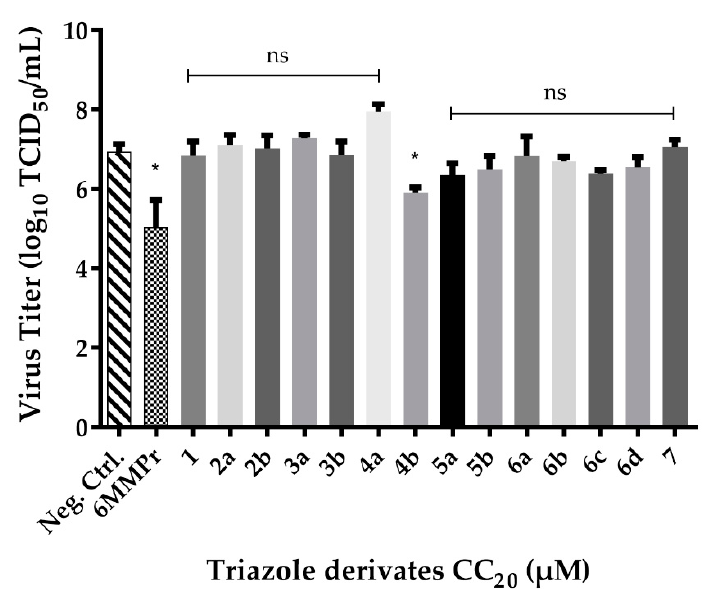
Figure 4. Graphic result of all triazole derivates in the screening test for anti-ZIKV activity. The screening test was made for post-infection with ZIKV MOI 0.1 and treated with CC 20 values from heterocyclic compounds discovered in the cytotoxicity test. After five days, the supernatant was collected and titrated by TCID 50 method. The experiment was conducted in triplicates and values are the mean and the standard deviation (SD). In the GraphPad Prism program, Dunnett’s ANOVA analysis was used to determinate the best compounds comparing with control. * = significative; ns = not statistically significant for p < 0.05.